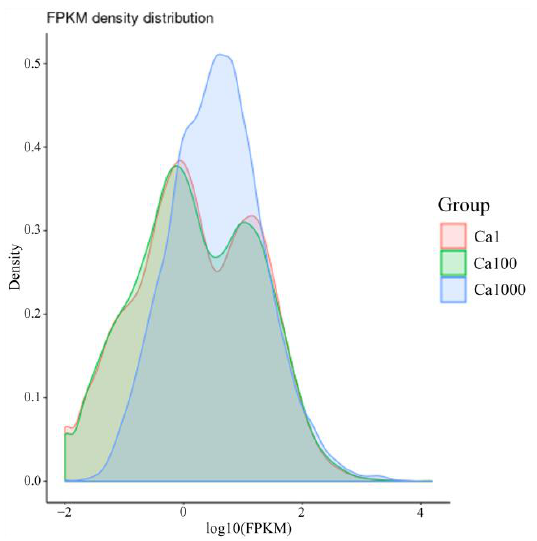
Figure 13. Effects of three concentrations of CaCl 2 on the gene density distribution.